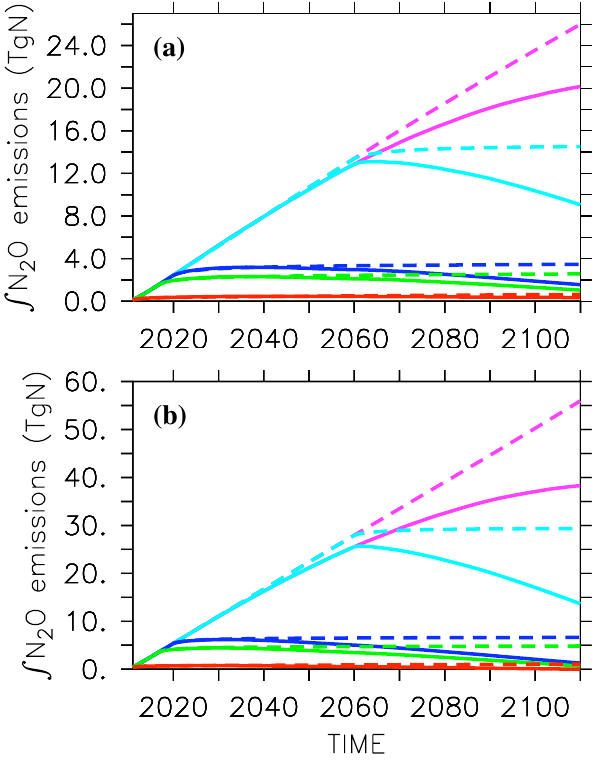
Fig. 7. Cumulative temporal integral of the fertilization-induced sea-air flux of N 2 O using the parameterizations of (a) Sunthar- alingam et al. (2000), and (b) Nevison et al. (2003) for oceanic N 2 O production (see text). Dashed lines refer to fertilization-induced N 2 O emissions in the fertilization region, solid lines refer to global fertilization-induced emissions. Units are TgN. Colour code as in Fig.